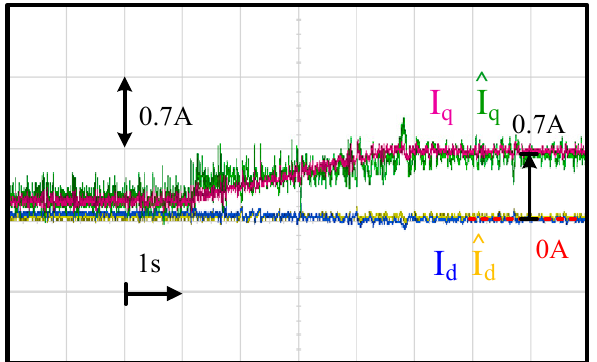
Figure 12. Experiment of machine current estimation performance (acceleration from 6 krpm to 42 krpm within 4 s and fan load).